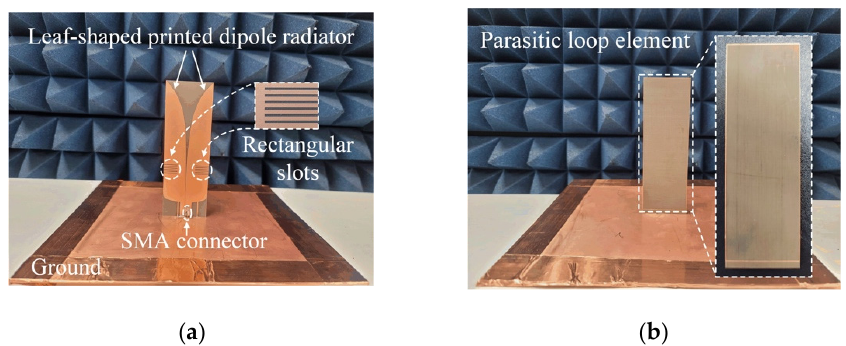
Figure 3. Photographs of the fabricated antenna sensor: ( a ) front view; ( b ) back view.